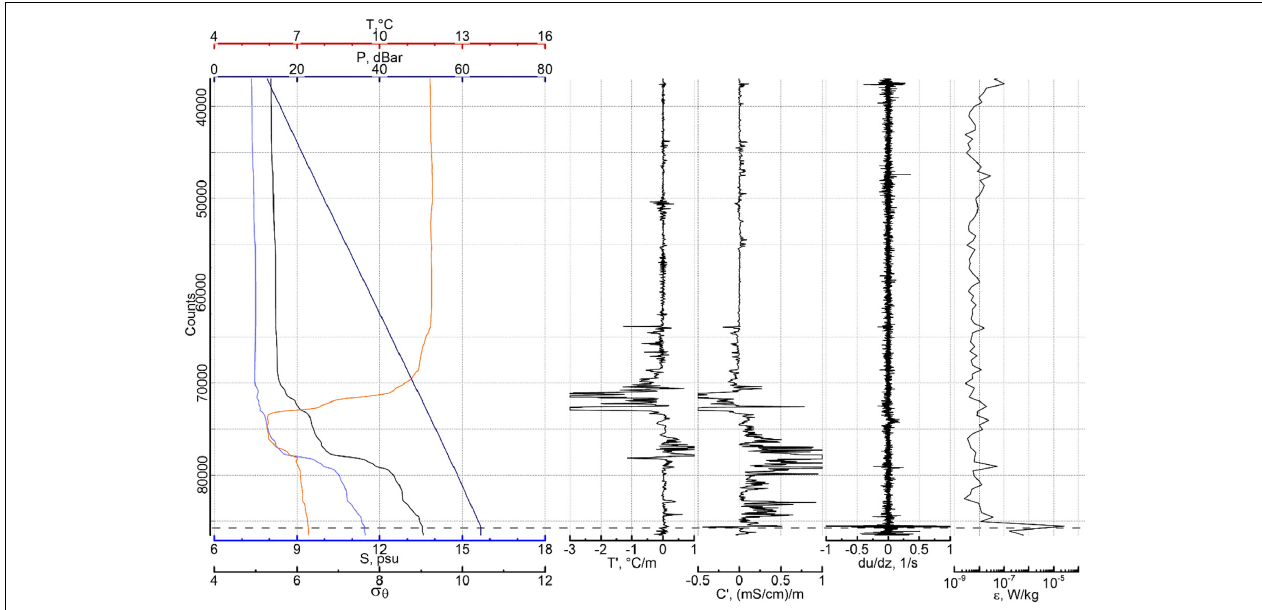
FIGURE 11 | Examples of non-turbulent bottom layer on the Słupsk Sill, the profile was registered on 18.10.2017, 14:03 at a position 55 ◦ 17.999 (cid:48) N, 16 ◦ 31.350 (cid:48) E. A westerly wind of 5–10 m/s prevailed. The presented variables are the same as in Figure 10A .